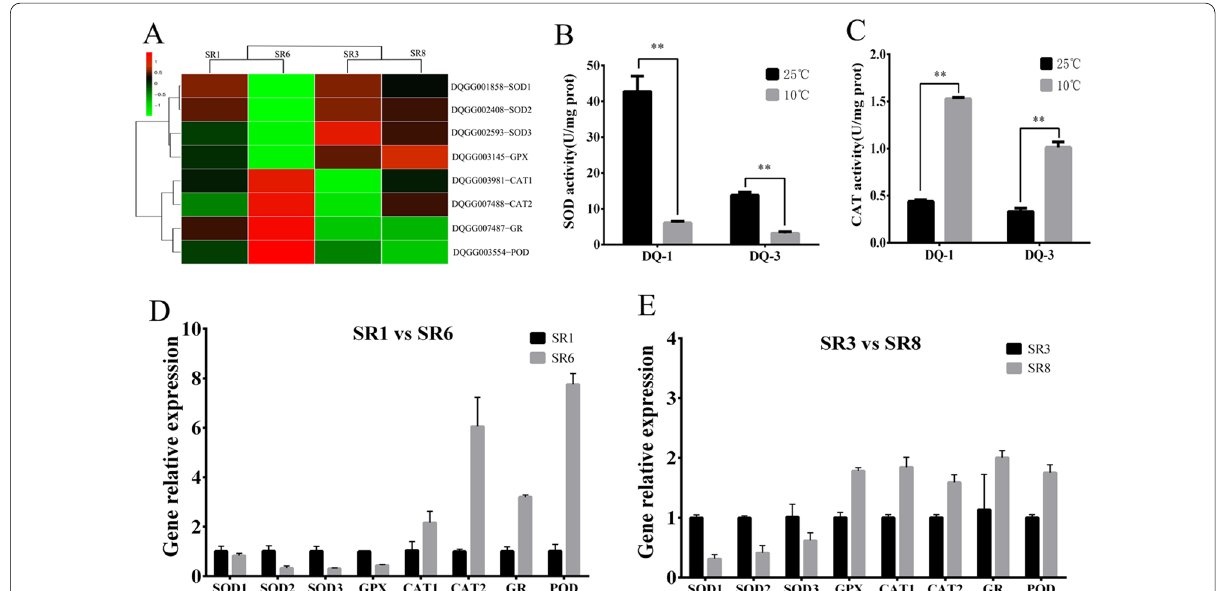
Fig. 6 Analysis of antioxidant enzyme activity and gene expression levels under the different temperature treatments. A Transcriptome comparative analysis of the expression of antioxidant enzyme genes between different treatments. B and C Changes in SOD and CAT enzyme activities in the DQ-1 and DQ-3 strains under the different temperature treatments. D and Validation of the expression levels of eight differentially expressed antioxidant enzymes (SOD1, SOD2, SOD3, GPX, CAT1, CAT2, GR and POD). The error bars represent the means triplicate